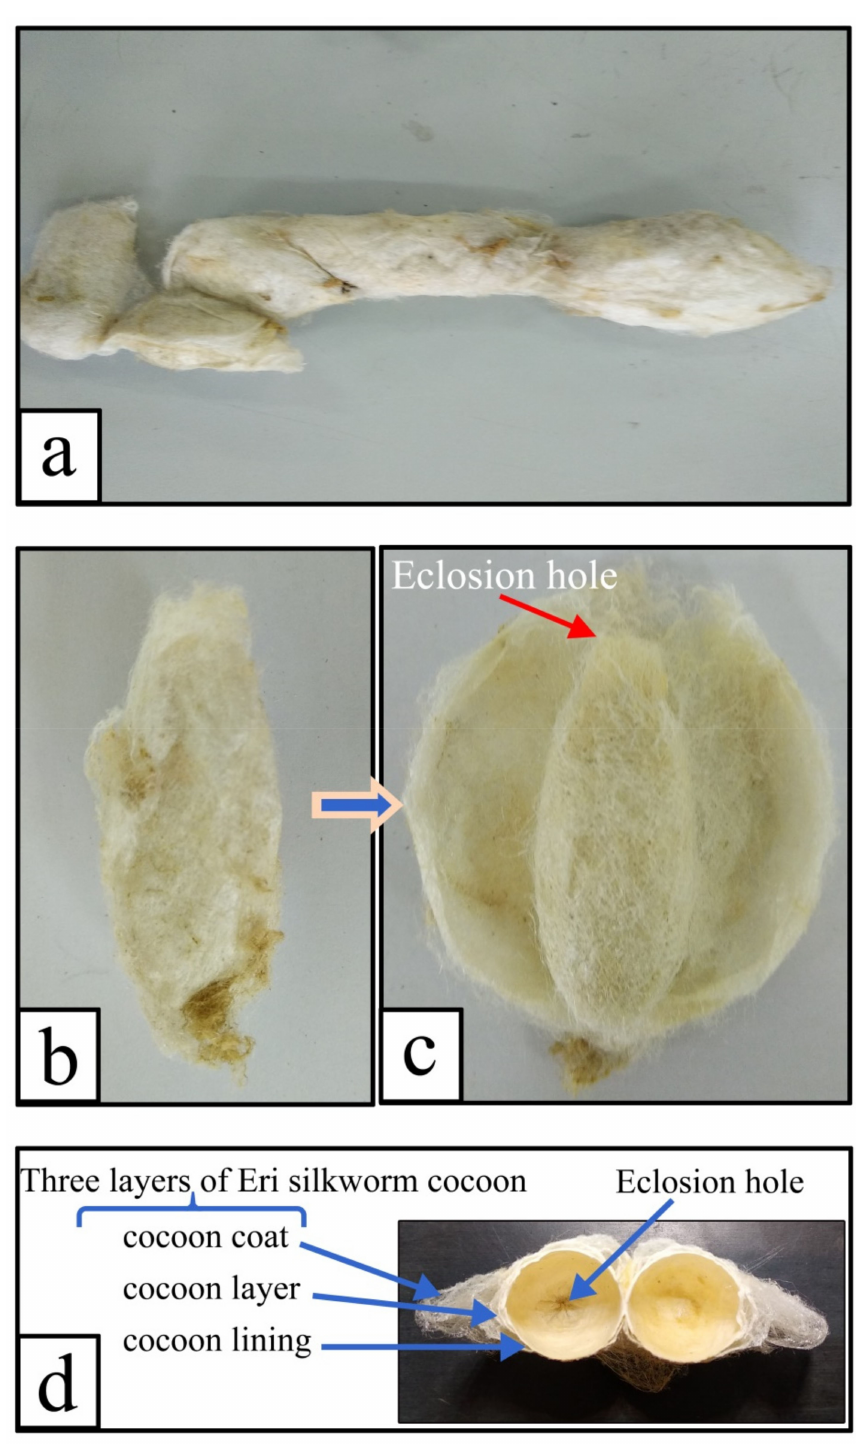
Figure 4. Digital images of the E cocoon: ( a ) diversity of E cocoon morphology; ( b ) intact E cocoon; ( c ) cocoon layer after the outer most layer had been cut open; ( d ) three layers (cocoon coat, cocoon layer, and cocoon lining) and eclosion hole of the